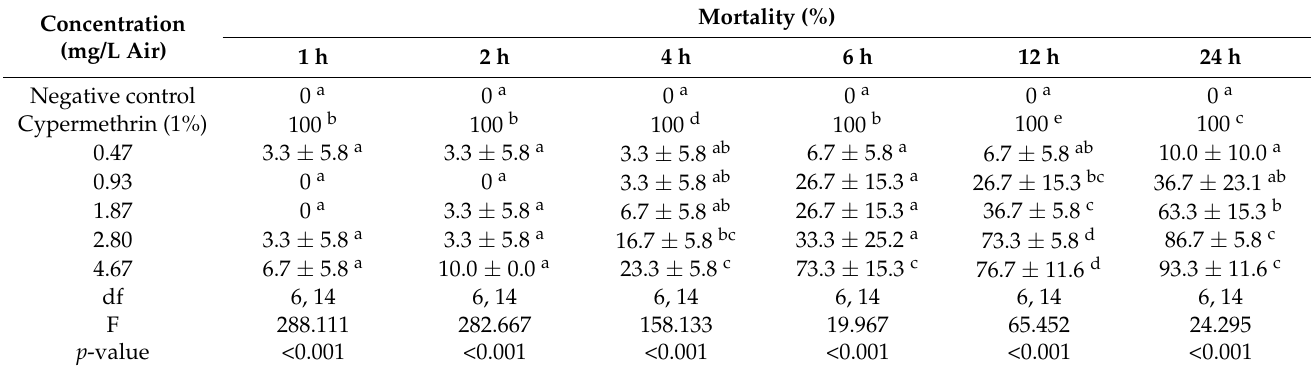
Table 4. Percent mortality (mean ± SD) of insecticidal activity of Plectranthus amboinicus essential oil against Stomoxys calcitrans by fumigant toxicity test at different